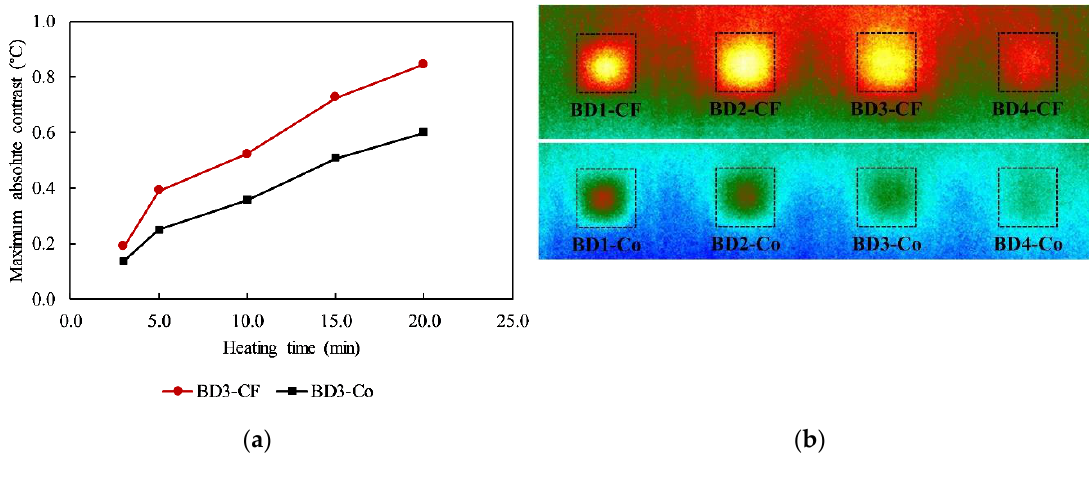
Figure 8. Effect of CFRP: ( a ) maximum absolute contrasts of delaminations BD3-CF and BD3-Co; ( b ) thermal image after cooling for 20 min in case of 15 min heating.